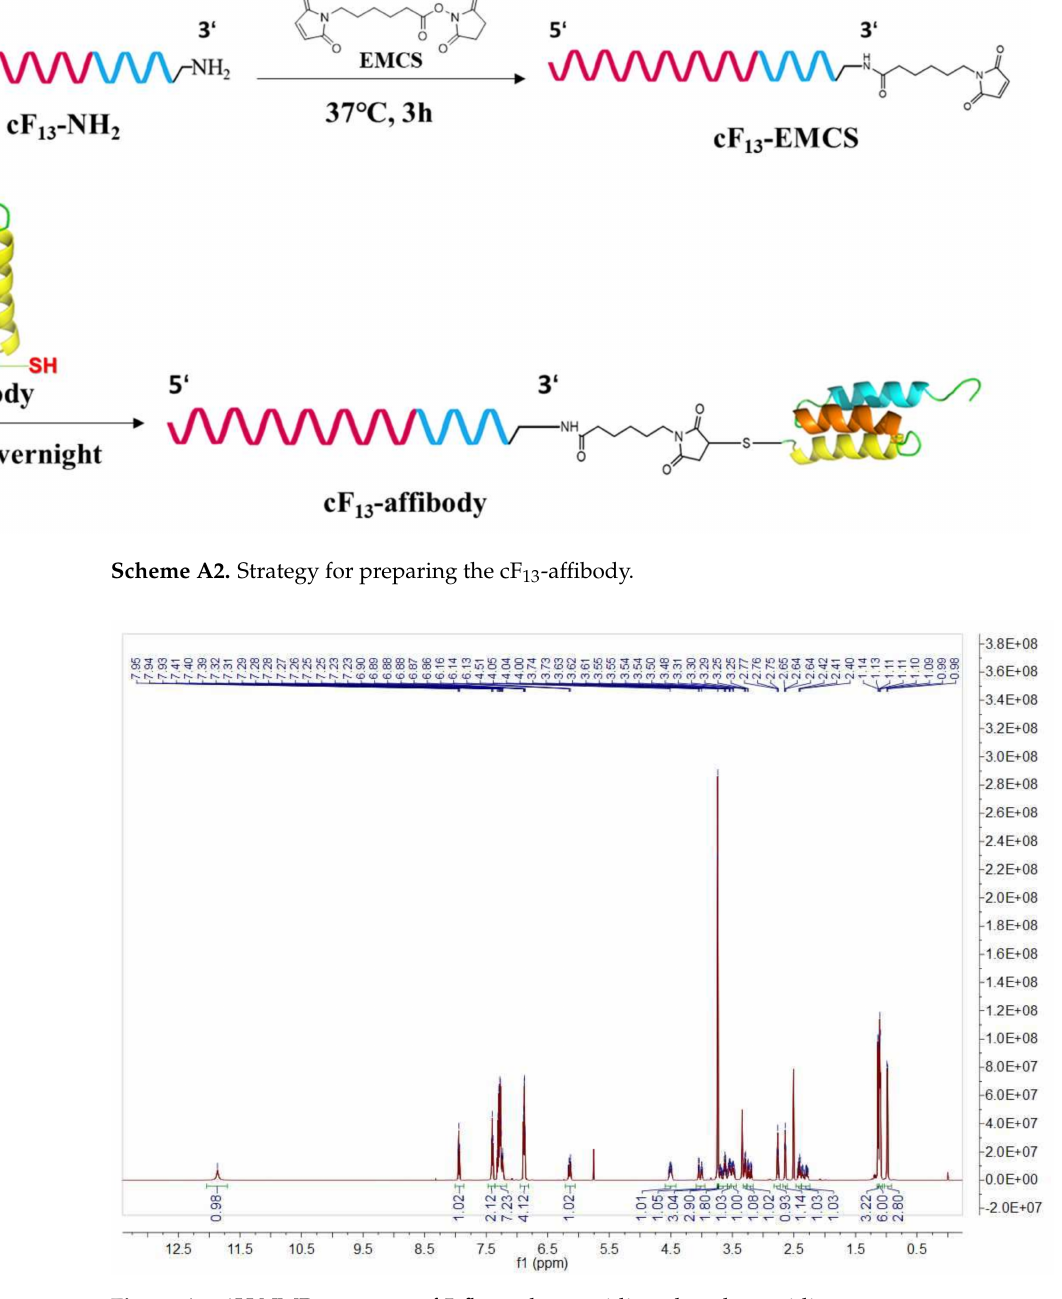
Figure A1. 1H NMR spectrum of 5-fluorodeoxyuridine